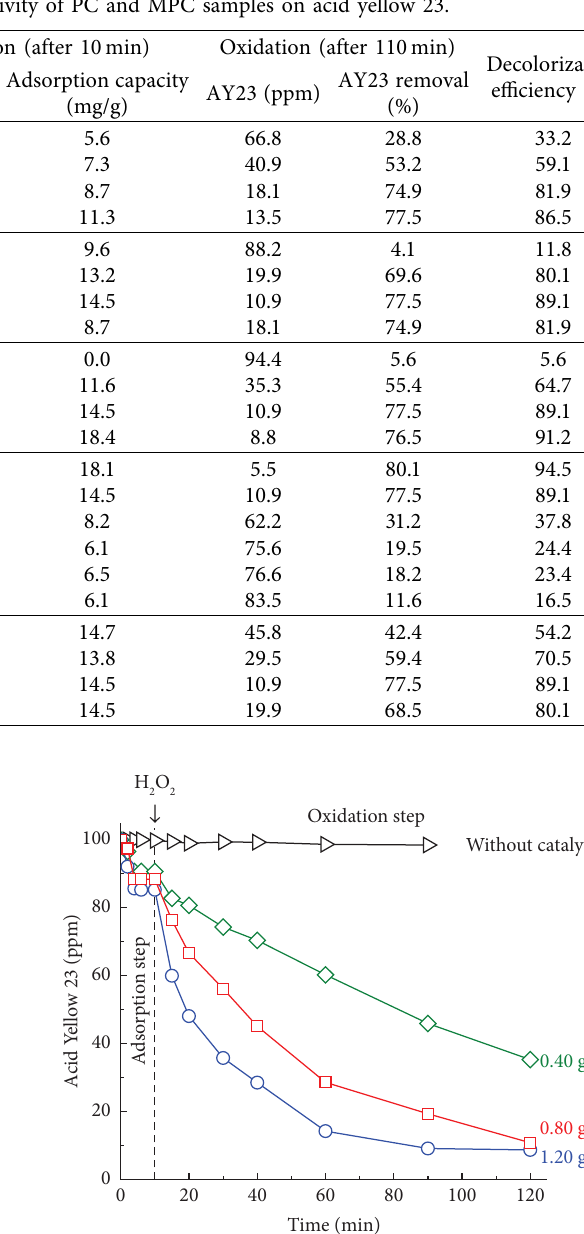
Figure 12: Efect of MPC catalysts prepared from diferent FeCl NF mass ratios on AY23 decolorization (0.80 g/L MPC-Rx-2.0h, pH 3.0, and 200 ppm H 2 O 2 ).